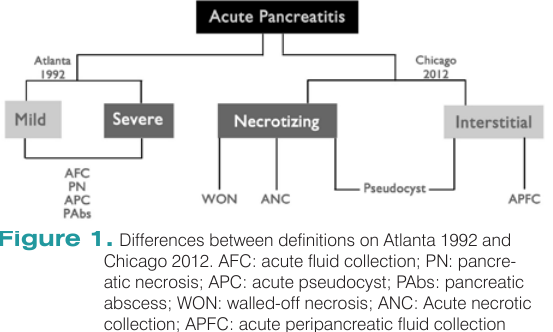
Figure 2. Revised terms in new consensus; ANC: acute necrotic collection; APFC: acute peripancreatic fluid